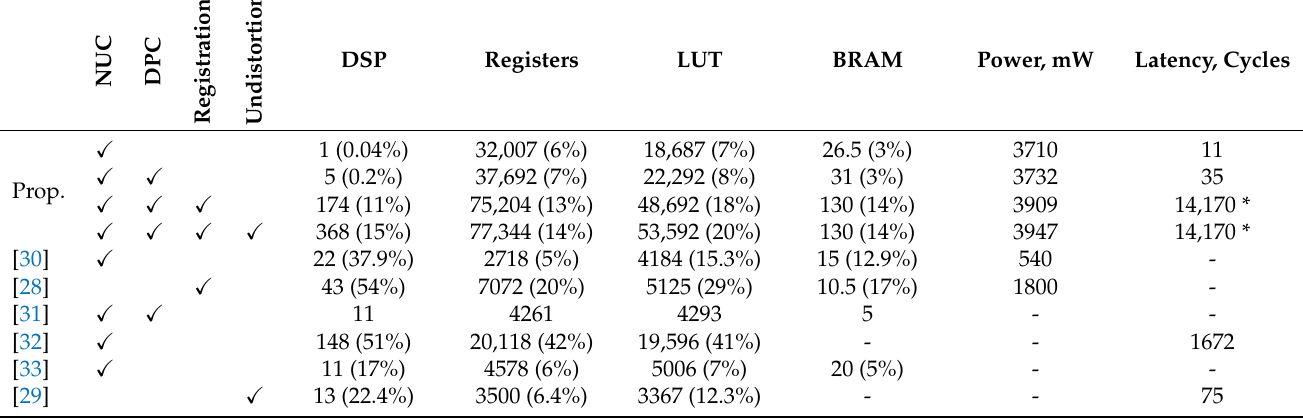
Table 2. Implementation results comparison with existing closely related